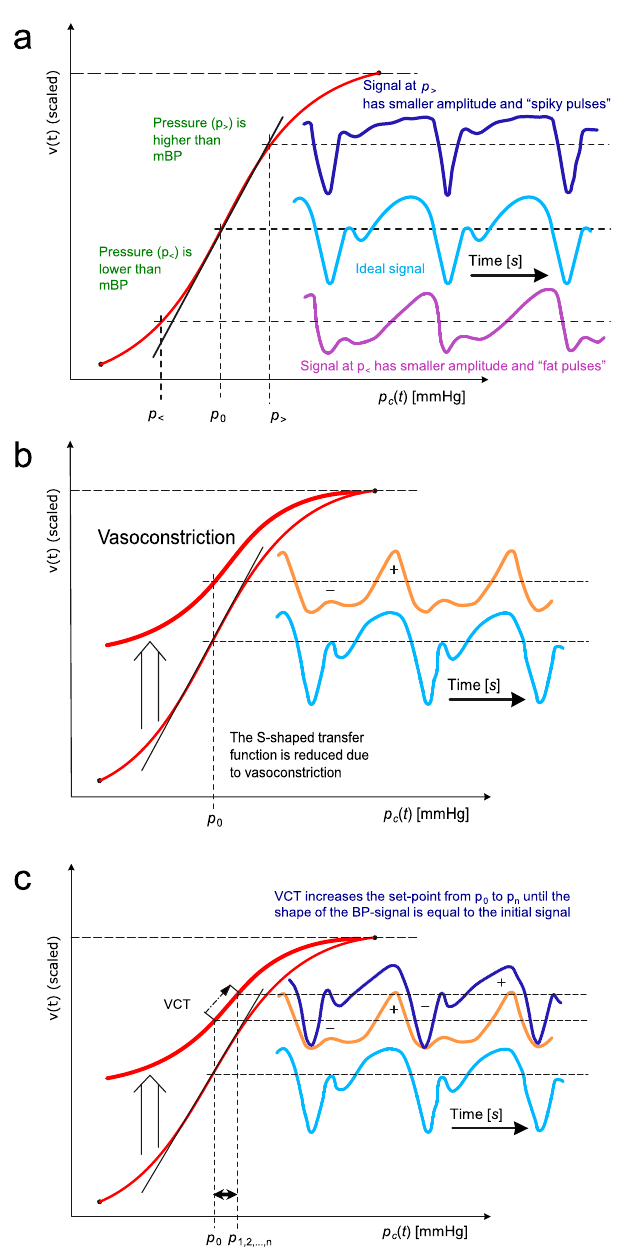
Fig. 4 S-shaped p - v transfer function. a The optimum pulsatile light signal v t ) (light blue trace) at optimal pressure p Pulse ( 0 has maximum amplitude with an integral over a full beat of zero. Suboptimal signals at too high ( p > ) or too low ( p < ) pressure are either spiky (dark blue trace) or fat (purple trace), respectively. mBP: mean blood pressure. b Vasoconstriction alters the S-shaped p - v transfer function and with it the pulse shapes of the light signals (from the light blue trace to the orange trace) – in particular the contributions of the positive ( + ) and negative ( − ) half-waves. c The setpoint p 0 and resulting p c ( t ) are altered after each heartbeat to p 1,2, … , n using the volume control technique (VCT). In particular, the pulse shape is restored by VCT after vasoconstriction (see dark blue trace).